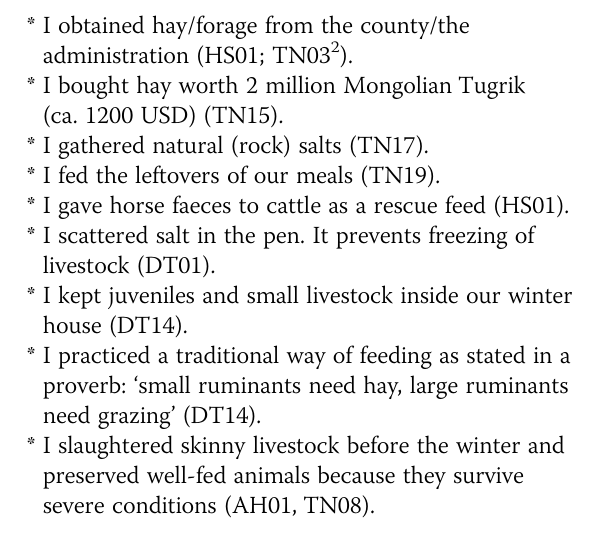
Table 3 Average livestock losses in the Mongolian Altai during the 2009/10 dzud across ethnic groups and wealth strata Group/stratum Variable Small ruminants a Large animals b